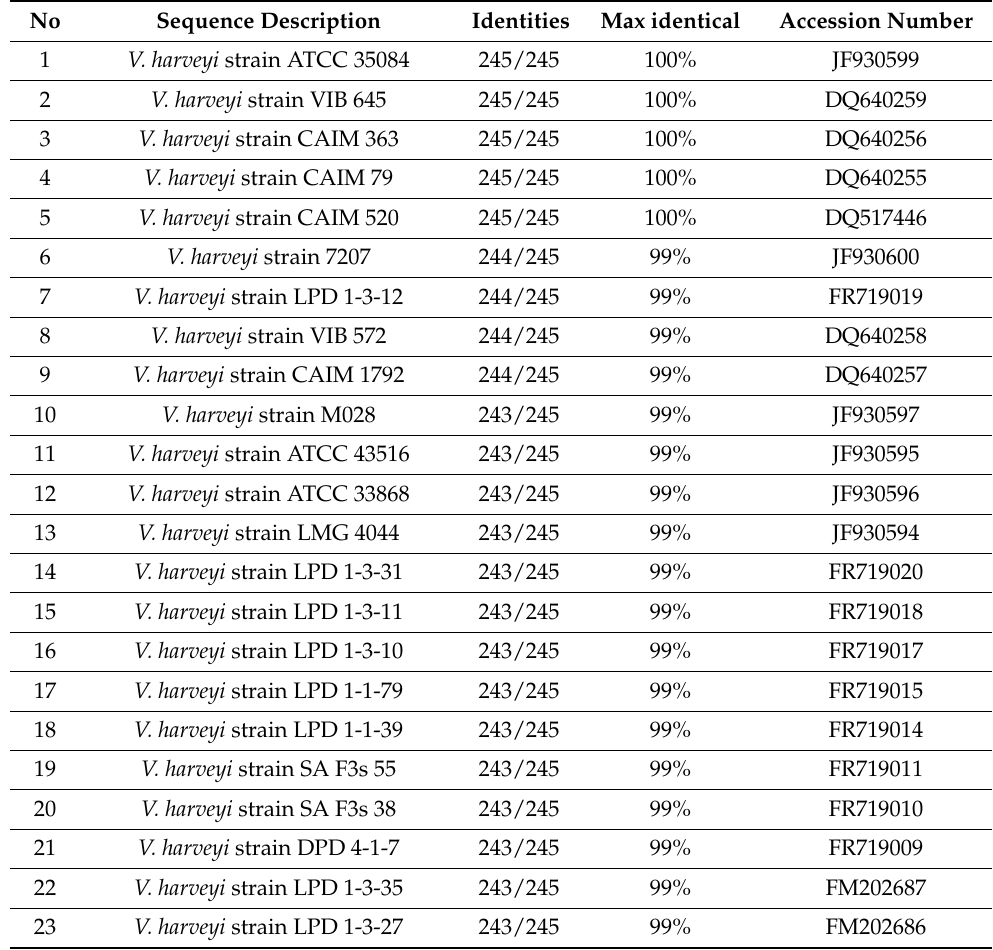
Table A1. BLAST search for the specific target sequence of Vibrio harveyi based on the toxR gene. The BLAST search produced a hit of 39 strains of the V. harveyi toxR gene (Parameters: nucleotide collection (nr/nt) and highly similar